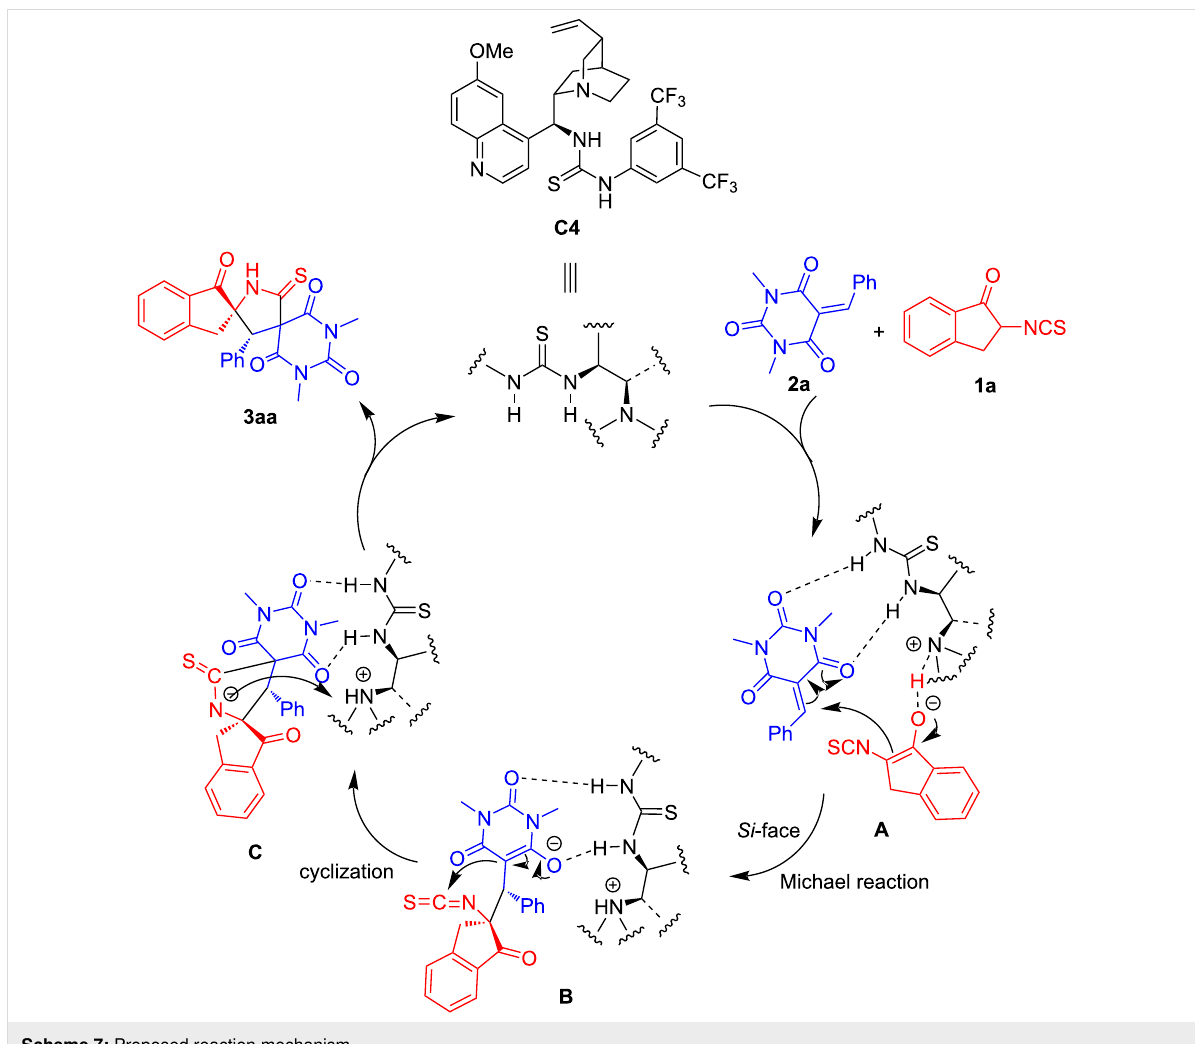
Scheme 7: Proposed reaction